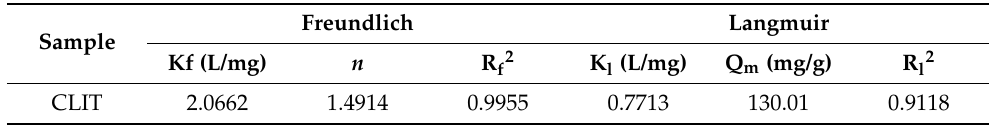
Table 3. Fitting parameters of adsorption isotherm models for